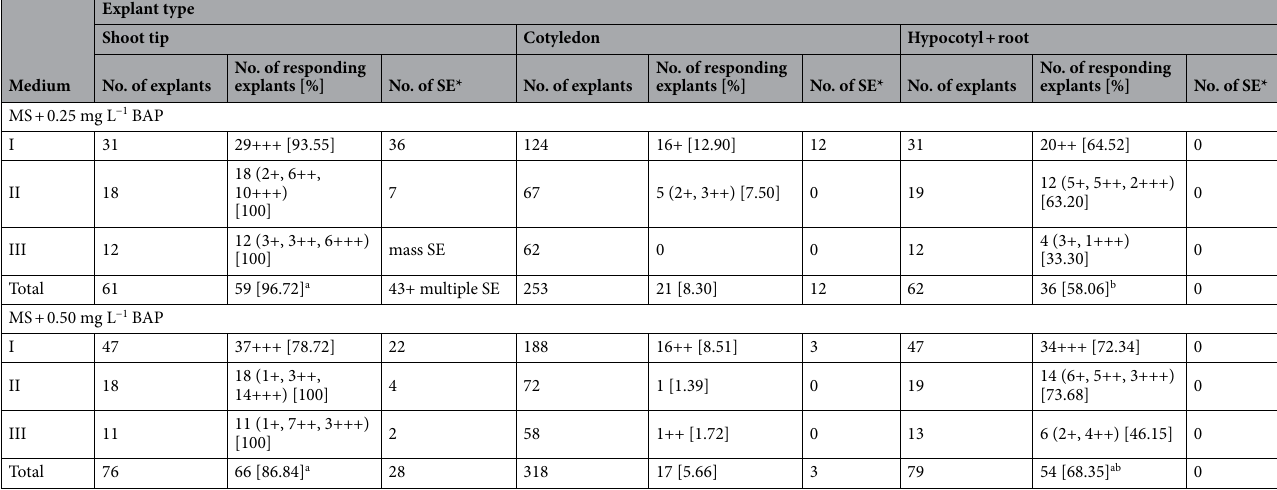
Table 2. Organogenesis and somatic embryogenesis of Pulsatilla patens after several months of culture. SE—Somatic embryos converted into seedlings; intensity of organogenesis: + single/several shoots, ++ several dozen/dozen shoots, +++ multiple, uncountable shoots. MS—Murashige & Skoog 38 medium. BAP— Benzylaminopurine. *Induction of somatic embryogenesis after explant/callus transfer on hormone free medium ½ MS + 2% saccharose. I–III—Repetitions of the experiments. Cotyledons were excluded from the statistical test due to the great differences in results between cotyledons and the remining explants. Two-way ANOVA showed statistical differences between type of explants (F (1, 8) = 22.298, p = 0.0015). Average values marked by the same letter do not differ significantly at p ≤ 0.05 as revealed by Tukey’s HSD post-hoc test.